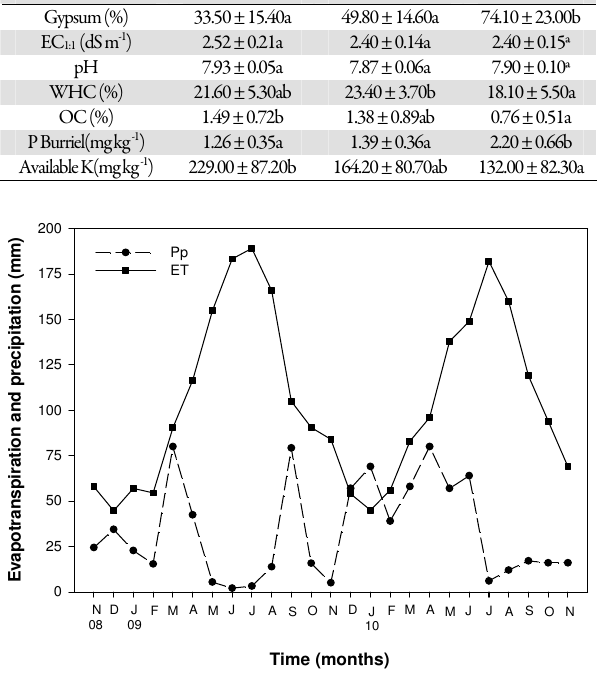
Fig. 1. Water deficit represented in function of monthly precipitation and evapotranspiration data registered by the nearest meteorological station, located in Chulilla related to a seasonal pattern, but the latter was lower in plot 3, which has the highest amount of gypsum (Table